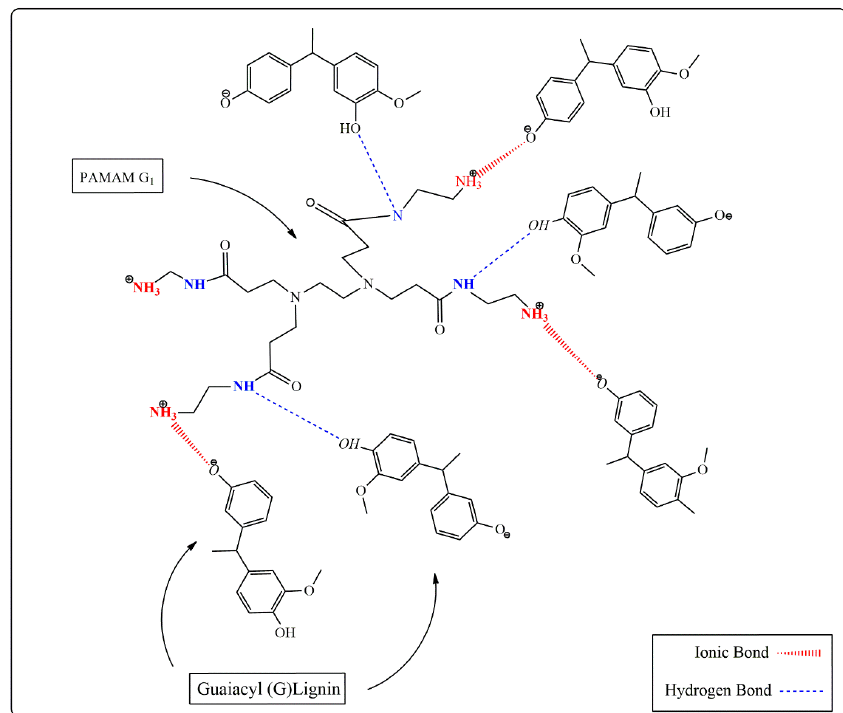
Figure 9. The possible ionic and hydrogen bonding between lignin and PAMAM.